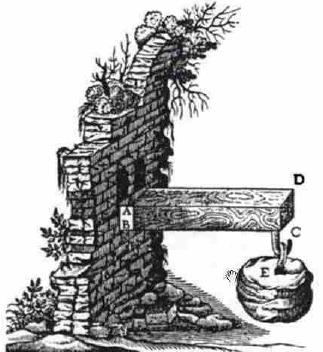
Figure 4. Galileo’s beam (Source: https://oll.libertyfund.org/title/galilei-dialogues-concerning-two- new-sciences, accessed on 20 March 2022).